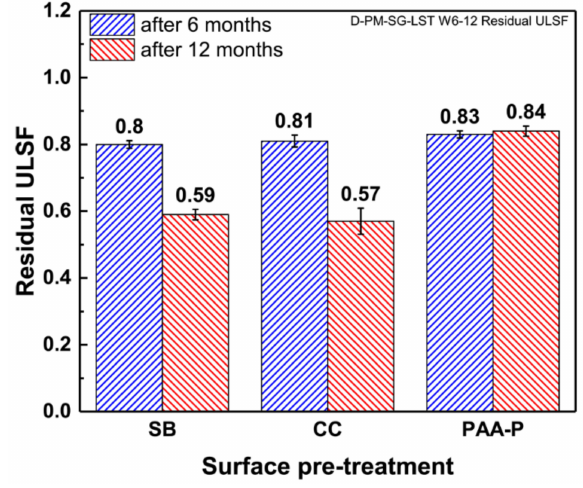
Figure 15. Residual strength (ULSF) of the SLS FSp joints after six and 12 months of outdoor